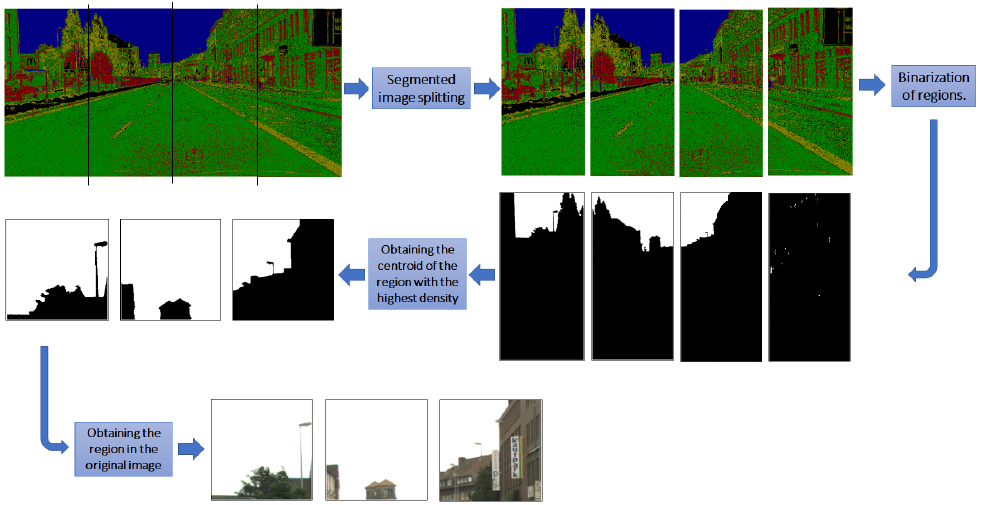
Figure 11. Image patches generated to validate the